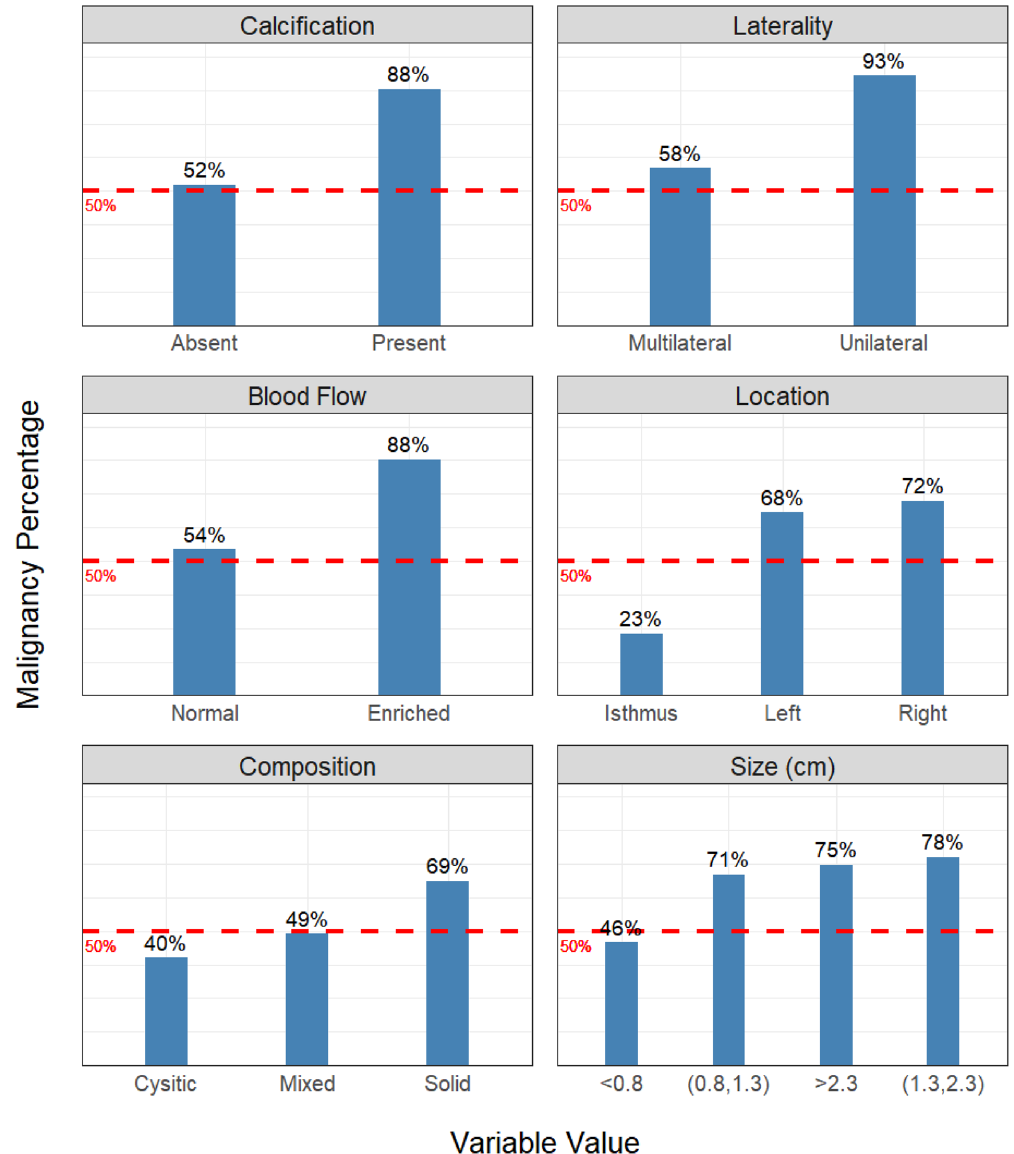
Figure 5. The percentage of malignant nodules corresponding to each value of the top-six important variables. A large percentage shows that the specific value indicates malignant nodules. A small percentage shows that the specific value is an indicator of benign nodules. A close-to-50% percentage shows no strong indication of the nodule malignancy.